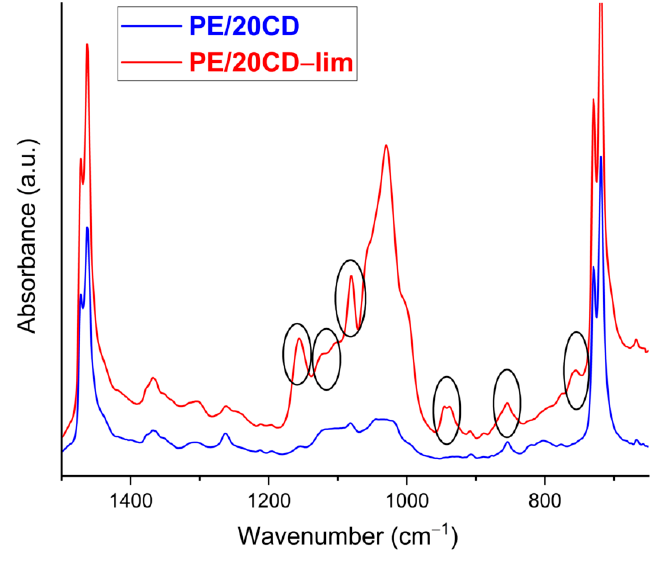
Figure 3. FTIR-ATR spectra of PE/20CD and PE/20CD-lim.